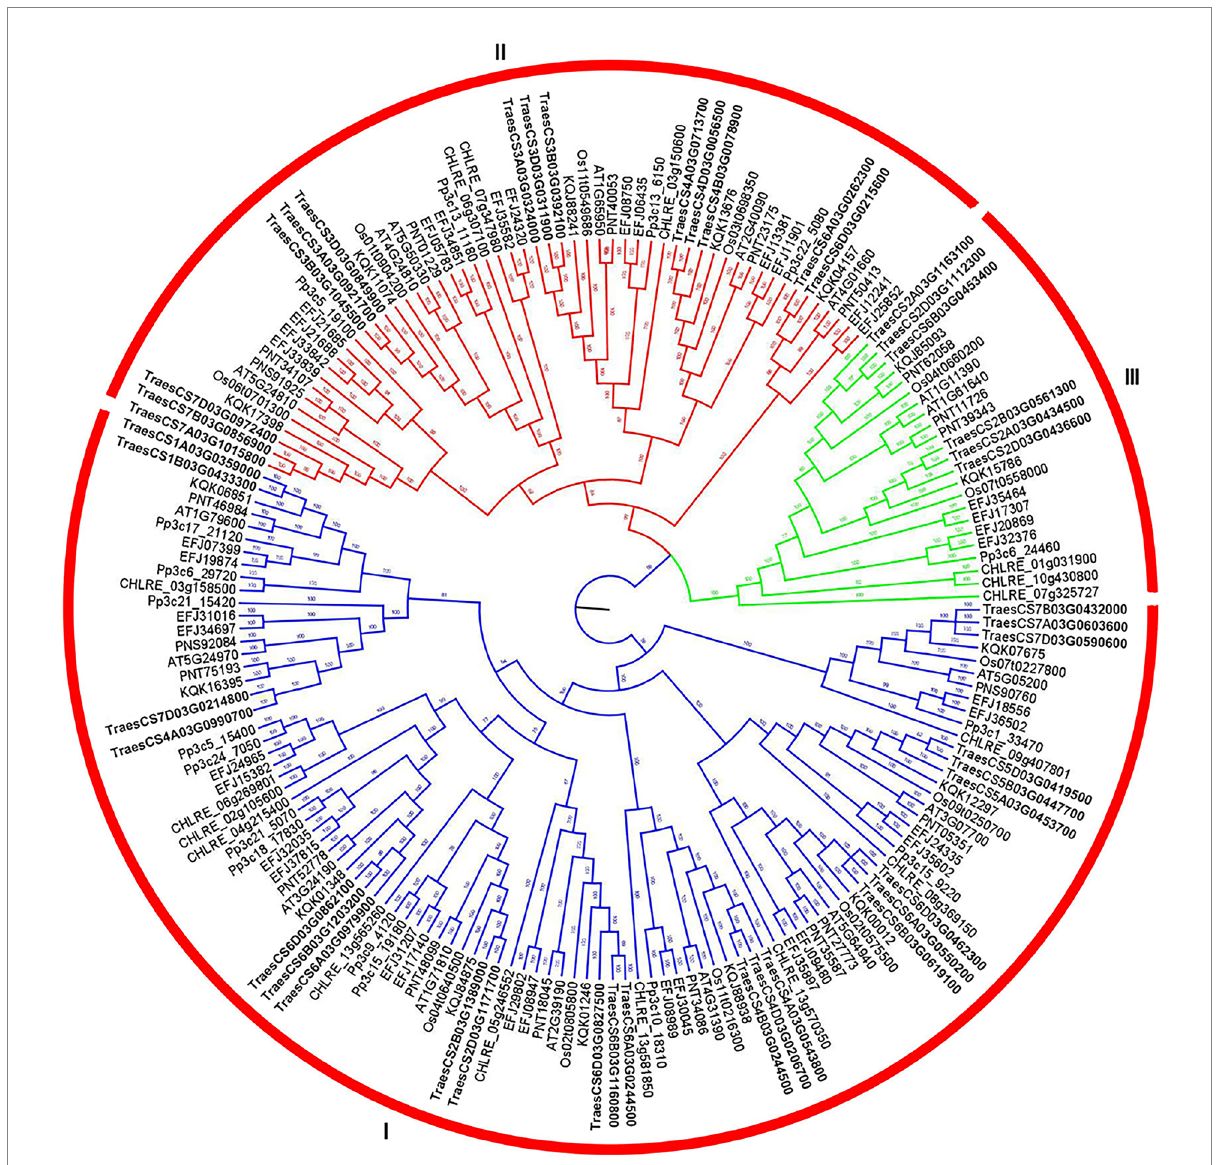
FIGURE 1 Bayesian phylogenetic tree of ABC1K gene family from Triticum aestivum , Arabidopsis thaliana, Selaginella moellendorffii, Physcomitrella patens, Populus trichocarpa, Brachypodium distachyon, Chlamydomonas reinhardtii , and Oryza sativa